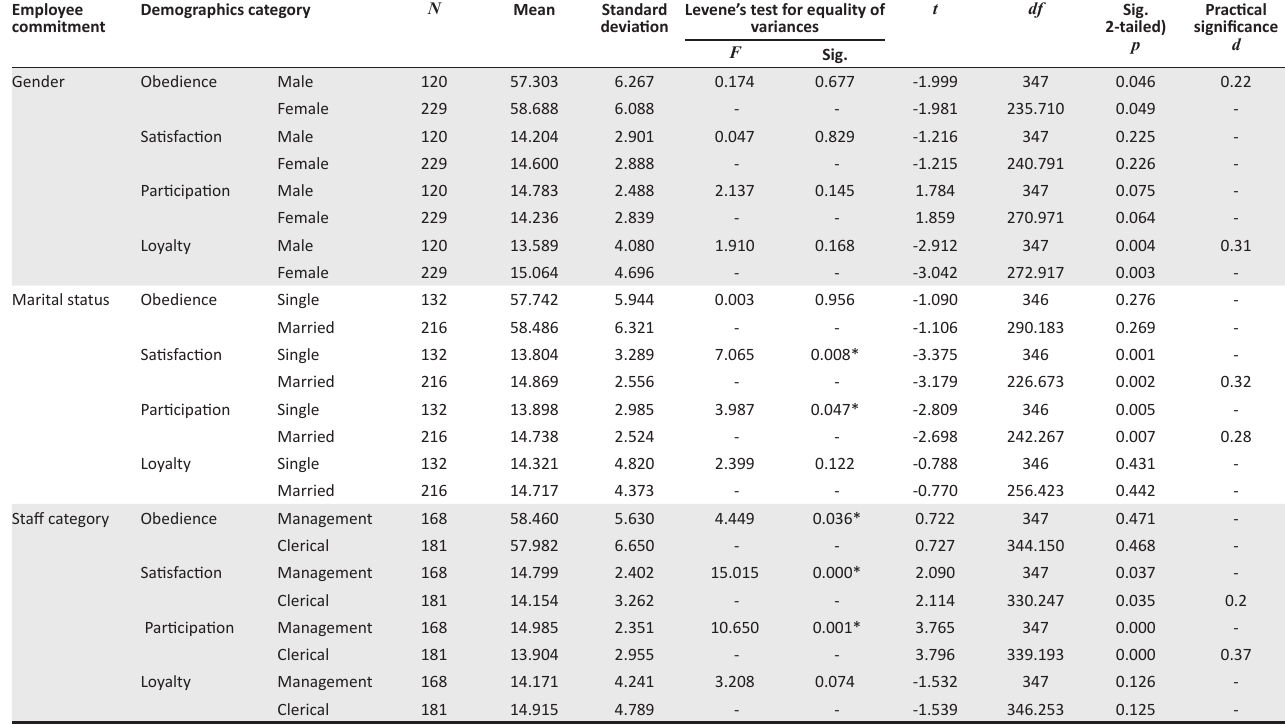
TABLE 5: Students’ t -test – Comparison of mean scores of gender, marital status and staff category in respect of employee commitment. Employee